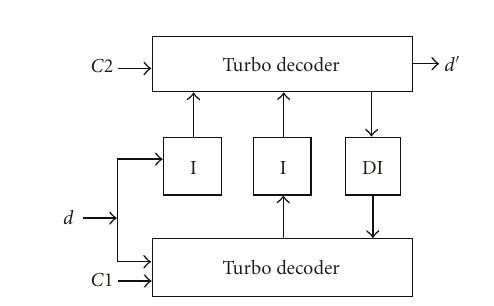
Figure 2: Typical turbo decoder.